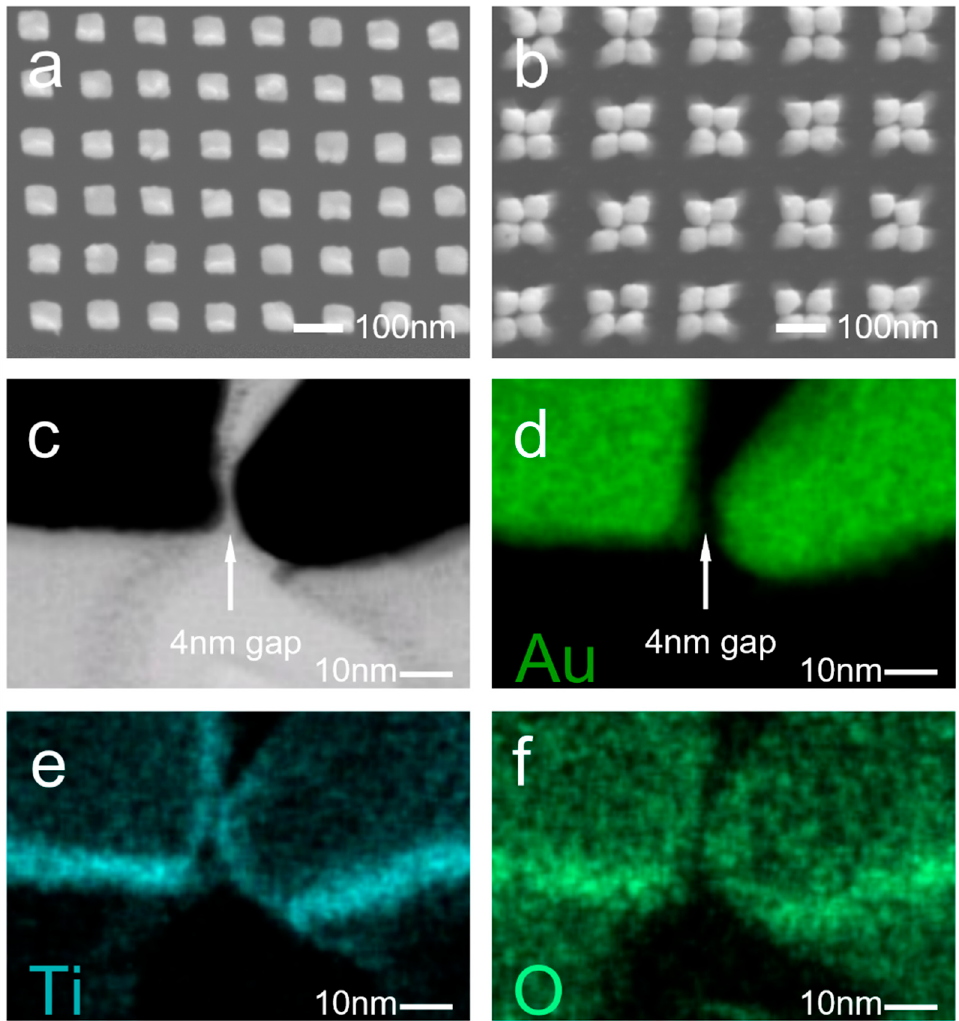
Figure 2. ( a ) SEM image of nanofingers before collapse. ( b ) SEM image of nanofingers after collapse. ( c ) TEM image of the dielectric nanogap between the collapsed nanofingers. ( d ) EDS mapping of Au in the TEM image. ( e ) EDS mapping of Ti in the TEM image. ( f ) EDS mapping of O in the TEM image.